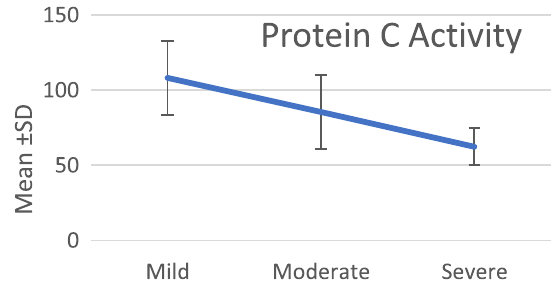
Fig. 1 Serum protein C in different disease severity groups